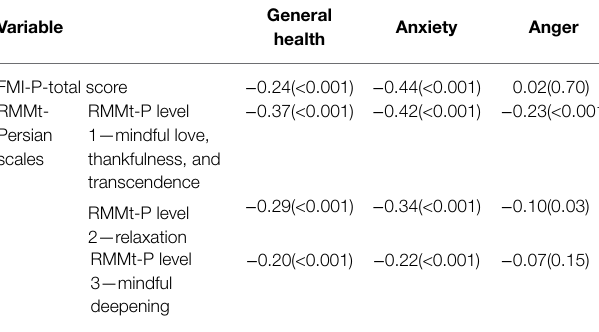
TABLE 2 | Correlation coefficient matrix for main study variables.